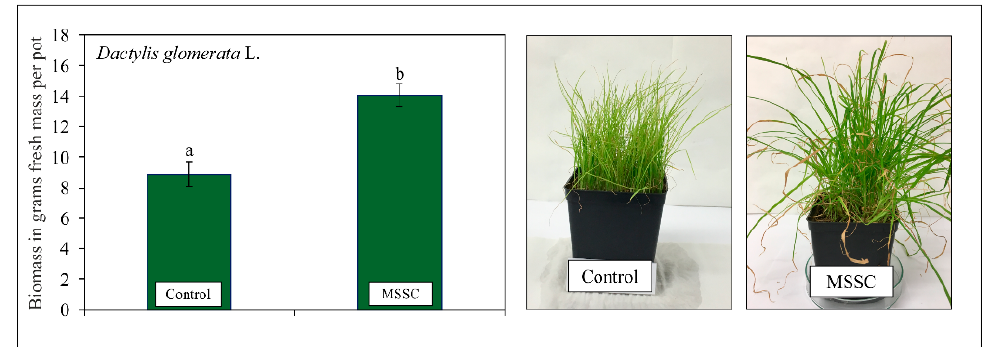
Figure 1. The average Dactylis glomerata L. biomass yield after the experiment (n = 3, mean ± standard deviation). Different letters indicate significant differences in biomass yield between control and MSSC-amended soil (ANOVA followed by Tukey’s honest significant difference test, p < 0.05).